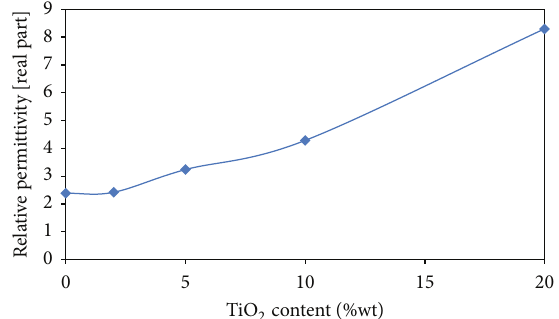
Figure 8: Effect of filler concentration on the real part of relative